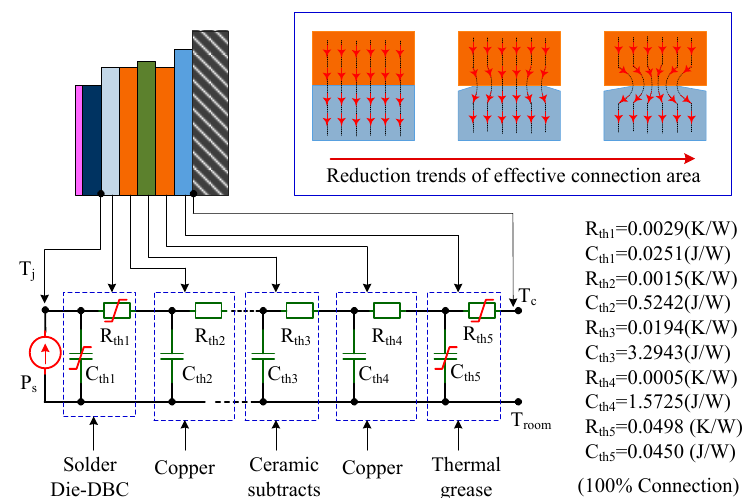
Figure 4. Equivalent non-constant thermal resistor-capacitor (RC) network considering the degradation effect.